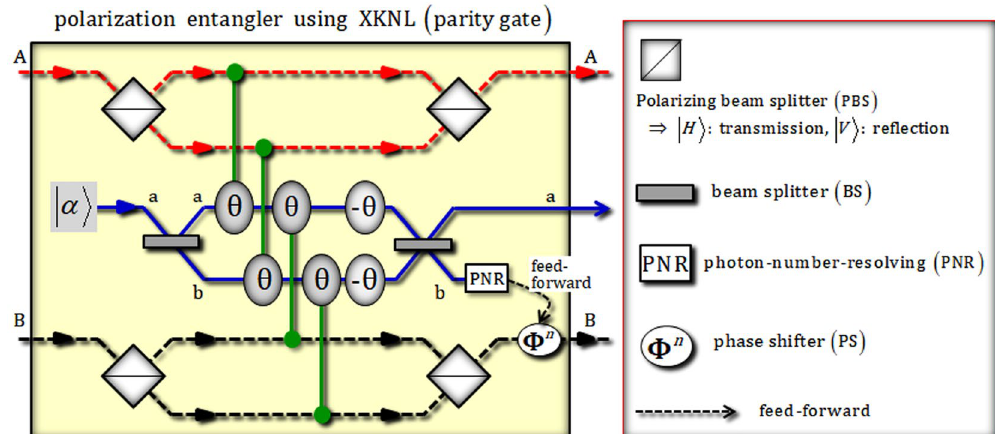
Figure 2. Plot representing the parity gate (polarization entangler) using XKNLs: a parity gate consists of XKNLs, quantum bus beams, photon-number-resolving measurement, and linearly optical apparatuses [PBSs, BSs, phase shifter (PS)]. The input state (product states of two photons) can be entangled between polarizations (single DOF) through this parity gate employing nonlinearly optical effects